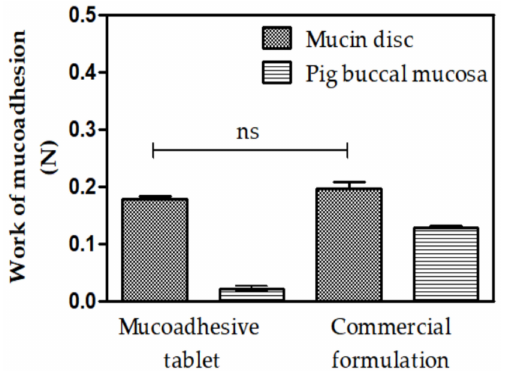
Figure 8. Work of mucoadhesion values for mucoadhesive tablet and commercial mucoadhesive formulations when in contact with mucin discs and pig buccal mucosa. The statistical significance was analyzed using variance analysis via Anova One Way; p ≤ 0.05. n.s.: no significant difference. Results are expressed as mean ± SD for n =